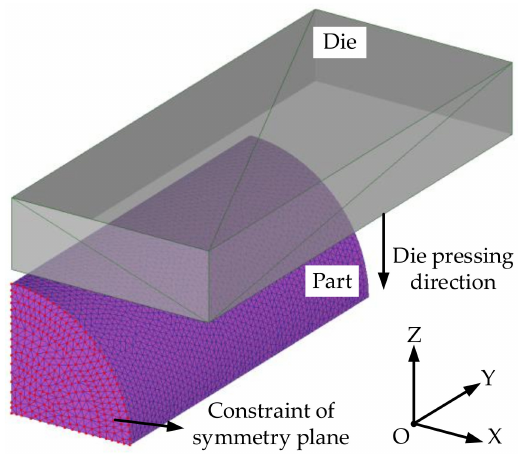
Figure 7. Forging simulation